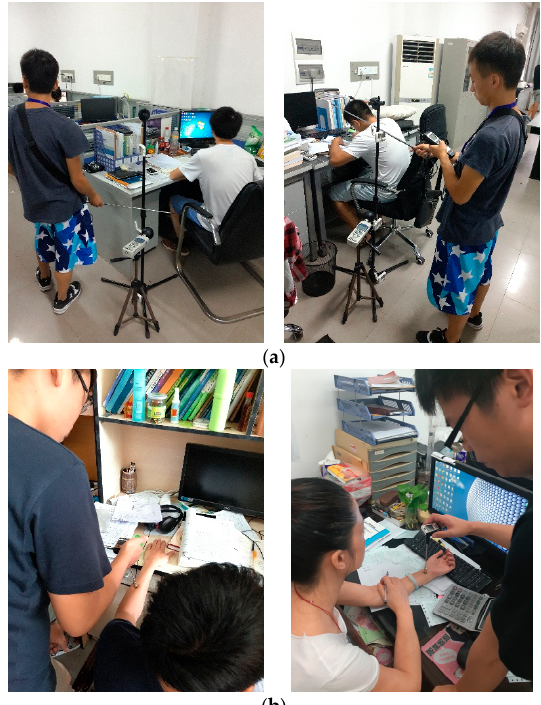
Figure 3. Physical and physiological measurements: ( a ) Physical measurements ( b ) Physiological measurements.